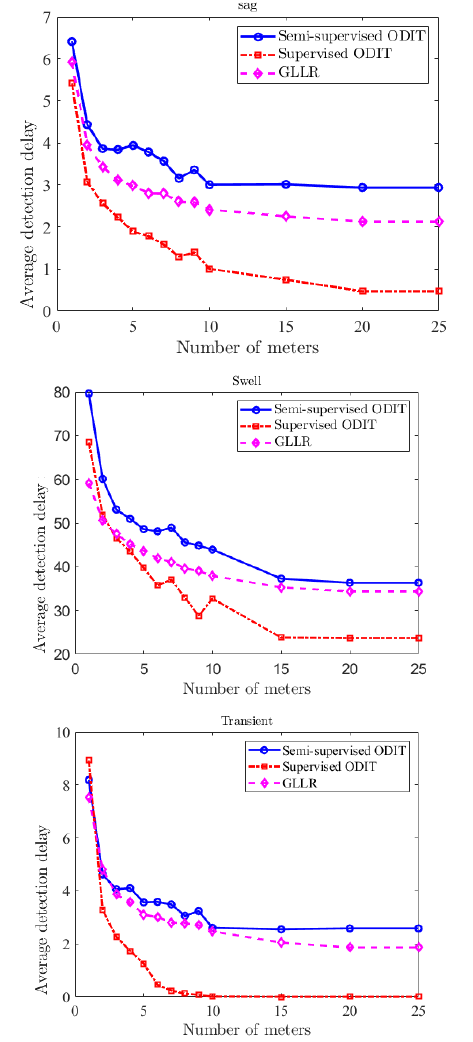
Figure 7. Average detection delay vs. number of meters for sag, sell, and transient disturbances. Detection delays are calculated for the fixed false alarm rate of